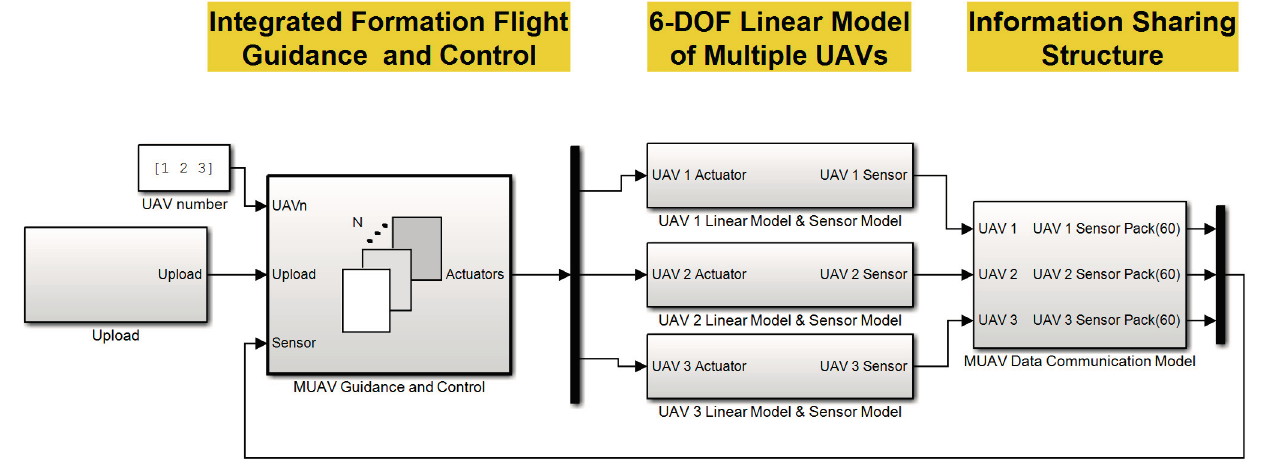
Figure 13. Simulation configuration in